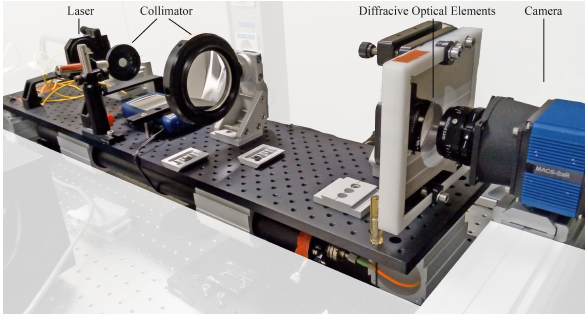
Figure 3. DOE Setup with the MACS Camera